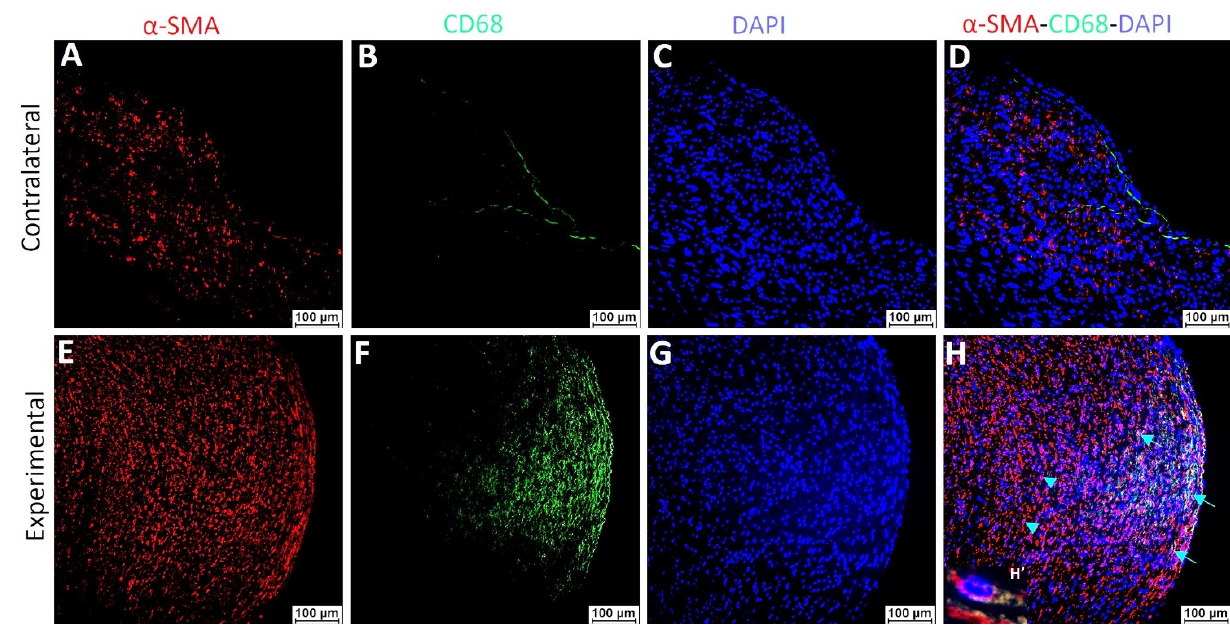
Figure 10. Dual immunofluorescence staining of α‐ SMA with CD68. Immunofluorescence for alpha ‐ smooth muscle actin ( α‐ SMA, panels A , E ), CD68 (a marker for macrophages, panels B , F ), DAPI (panels C , G ), and merged images (panels D , H ). Control ‐ arteries without plaque (Contralateral) and experimental ‐ arteries with plaque (Experimental). DAPI (4 ′ ,6 ‐ diamidino ‐ 2 ‐ phenylindole). The arrows indicate dual positive cells while the arrowhead indicates immunopositivity for one protein. Inset in panel H (H’) shows the co ‐ localization of α‐ SMA and CD68; the inset correspondence to the dual positive cells pointed by the right lower arrow).